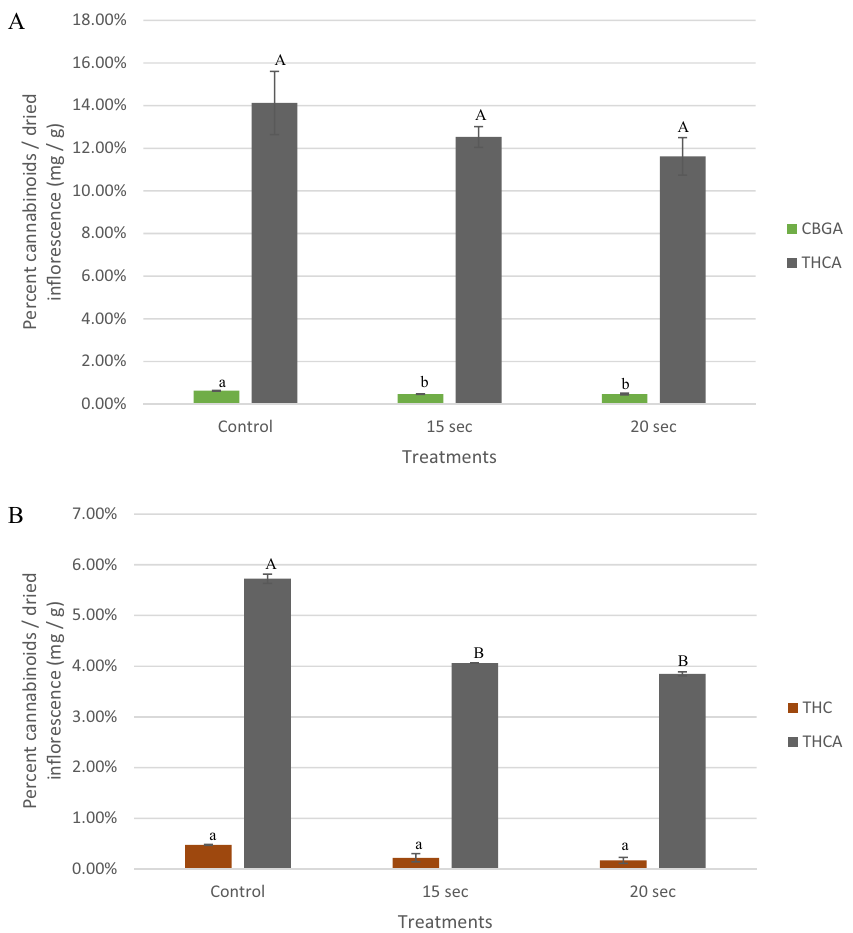
Figure 1. Percentage of different cannabinoids (CBGA, THC and THCA) in noncommercial inflorescences calculated as relative cannabinoid dry weight per inflorescences for the first ( A ), and second experiments ( B ). In each experiment, inflorescences were exposed to a steam treatment of 15 s at 65 °C and 20 s at 70 °C, and compared to an untreated control using two separate strains cultivated in the ARO licensed facility. Cannabinoid values at low concentrations (> 0.5%) in the untreated control are not shown. Values compared for each cannabinoid between treatments, with a different letter are significant, according to Tukey HSD (α =